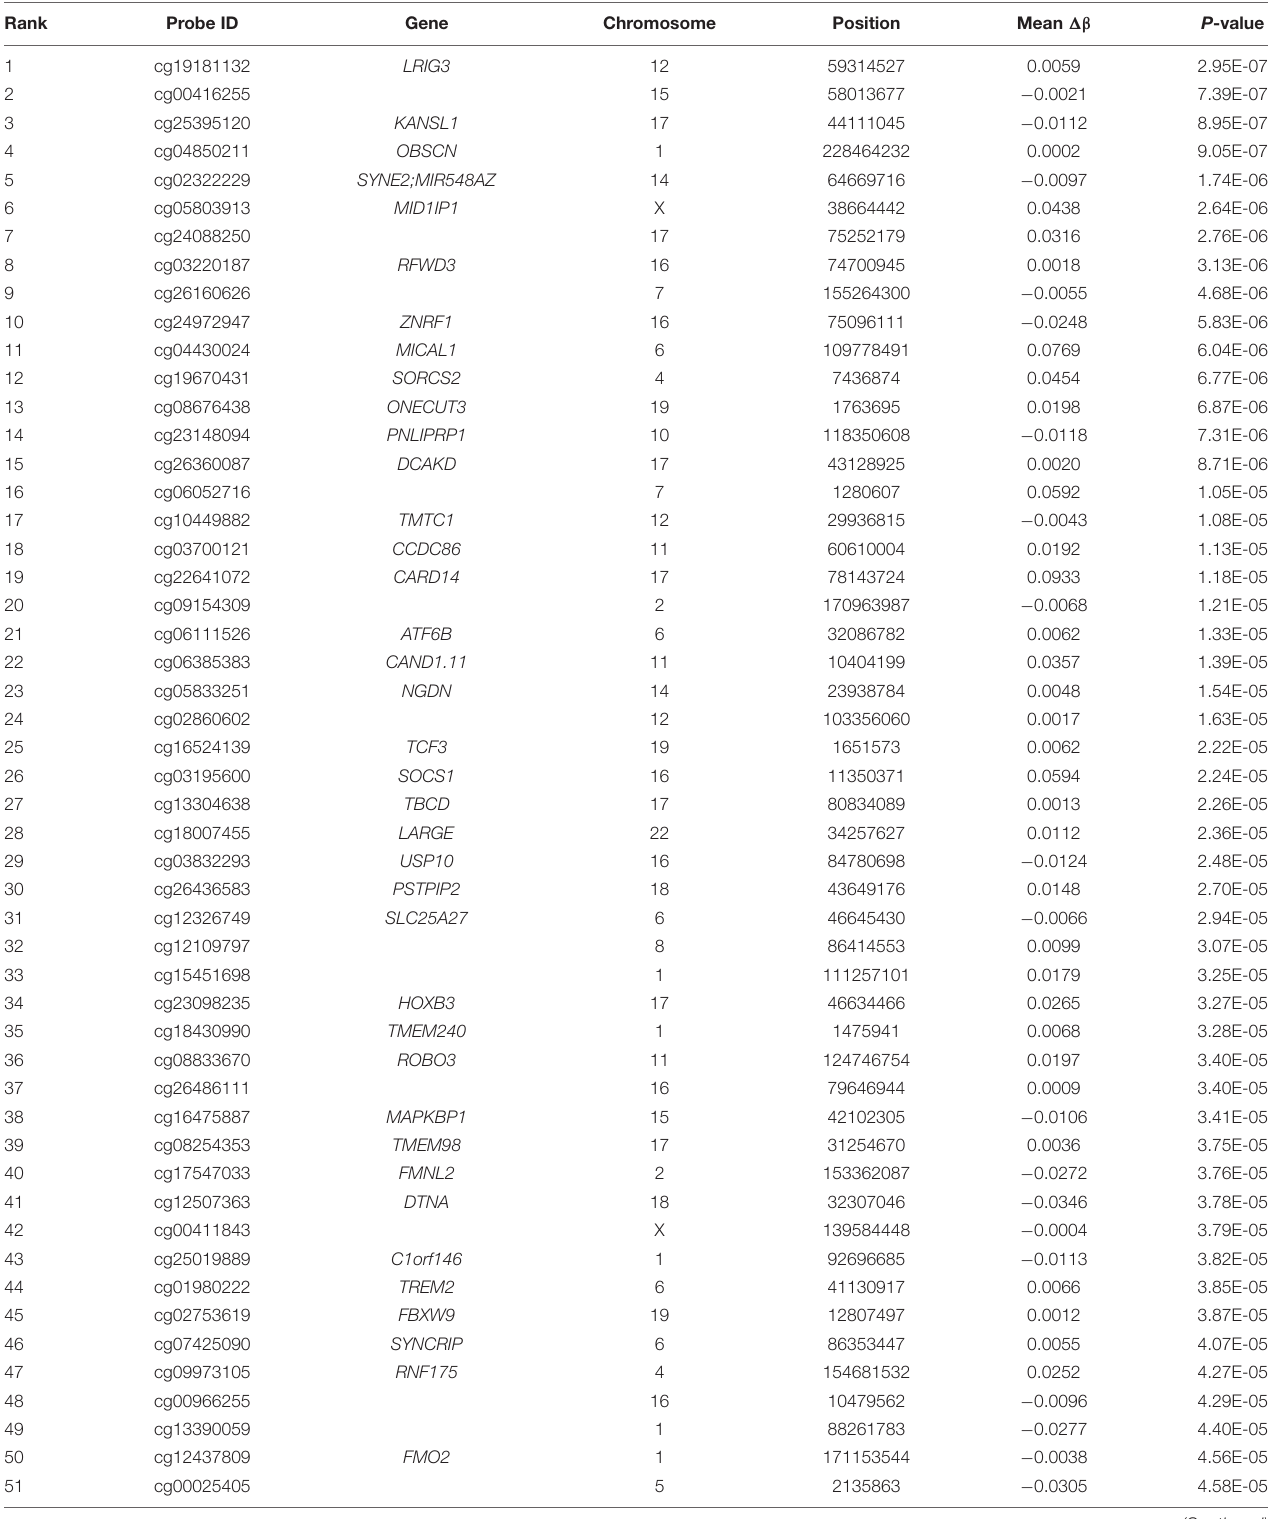
TABLE 2 | Top 61 differentially methylated CpG sites identified in ADHD-discordant monozygotic twin pairs, ranked by statistical significance and mean (cid:49) β (calculated as DNA methylation level of control twin minus ADHD